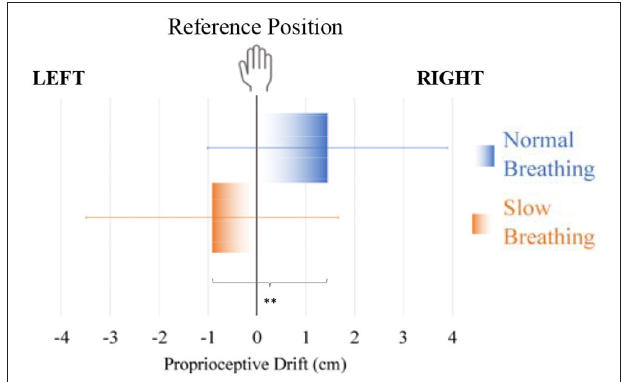
FIGURE 6 | Comparison of proprioceptive drift (cm) from the reference position of the hand (0) in conditions of Slow Breathing and Normal Breathing, with means and standard deviations. ** p < 0.01 (pairwise t- test between conditions of Slow Breathing and Normal Breathing).